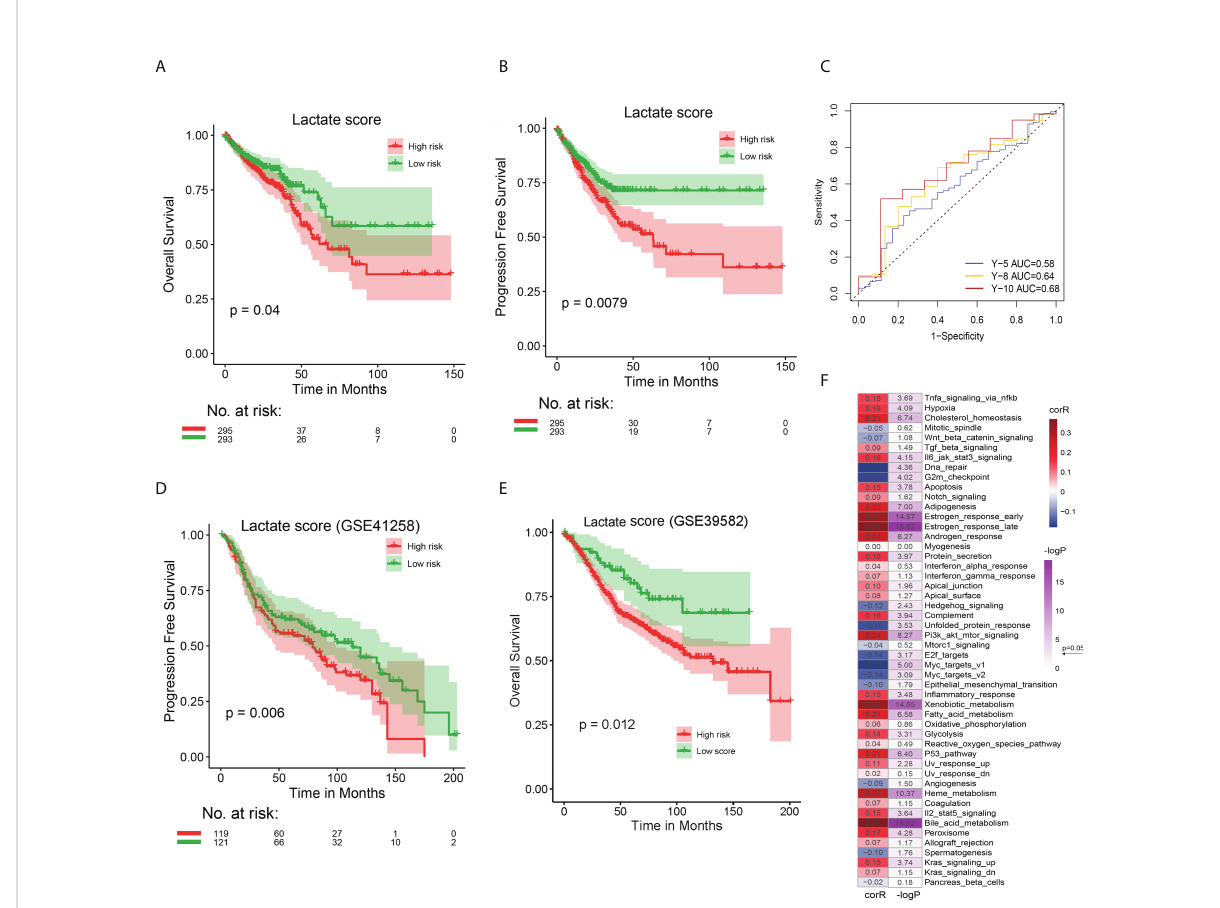
FIGURE 4 Prognostic performances of lactate score in TCGA COAD and GEO CRC cohorts and its association with hallmark pathways (A) The OS analysis of high and low risk groups in TCGA COAD cohort. (B) The PFS analysis of high and low risk groups in TCGA COAD cohort. (C) The ROC curve to evaluate the performance of lactate score by calculating the AUC. Prediction of 5-, 8-, and 10-year survival was performed. (D) The PFS analysis of high and low risk groups in GEO CRC cohort to validate the effect of lactate score. (E) The OS analysis of high and low risk groups in GEO CRC cohort to validate the effect of lactate score. (F) Correlation between lactate score and hallmark pathway activity. The activity of hallmark pathways was calculated by GSVA. The correlation coef fi cient and P value were evaluated by Spearman test. In (A, B, D, E) , P value has been derived from a log-rank